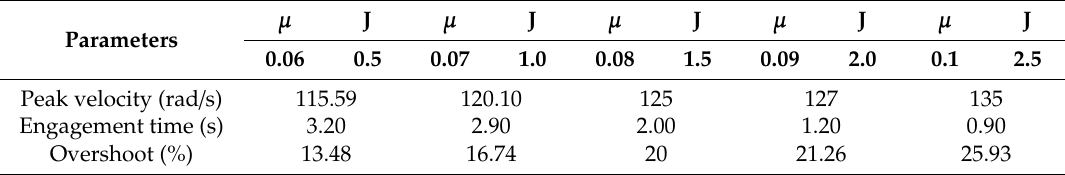
Table 4. The performance of the sliding velocity of the